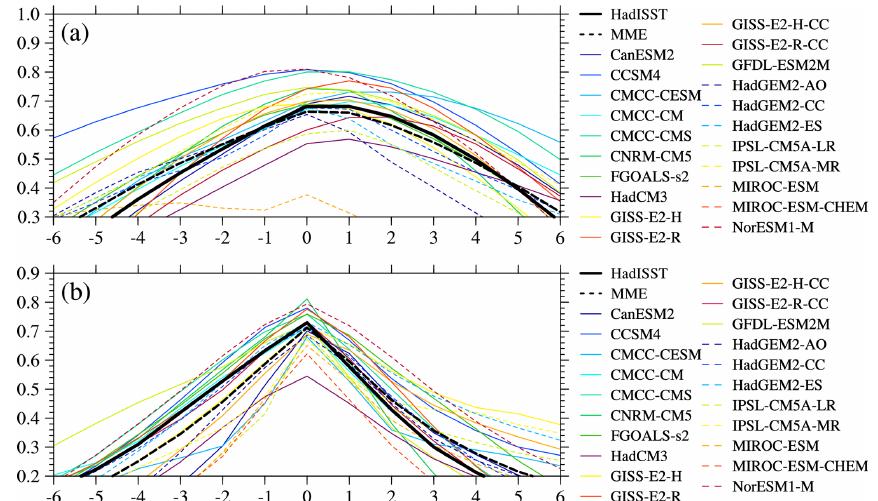
Figure 12. The lag–lead correlation coefficient of the PIOAMI with the Niño3.4 index (a) and IOD index (b) . Ordinate represents the correlation coefficient, and abscissa is the lag in months: positive (negative) for the Niño3.4 index or IOD index (PIOAMI) leading PIOAMI (Niño3.4 index or IOD